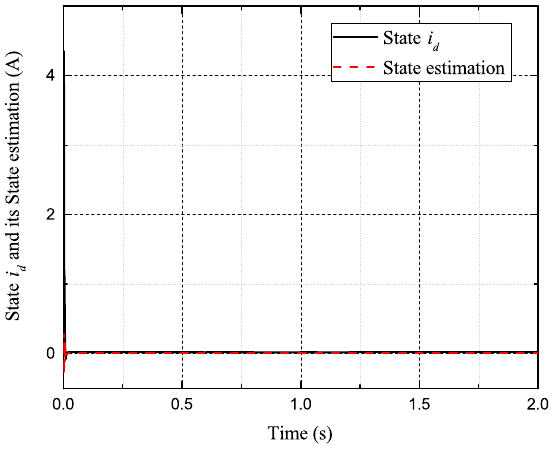
Figure 5. State i d and its estimated value ˆ i d .